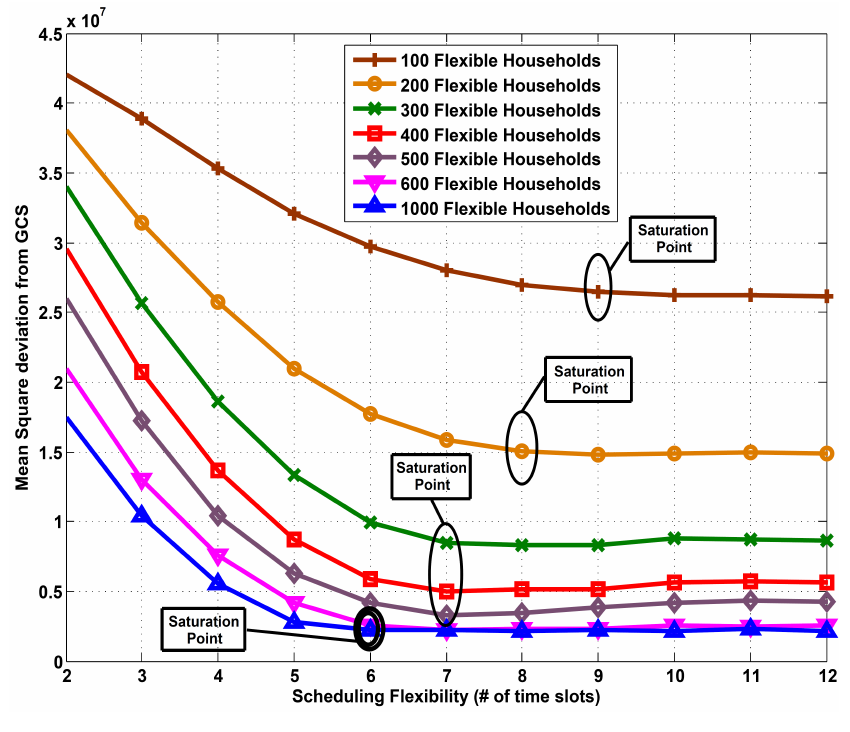
Figure 7. Participation rate of households vs . saturation point: partially distributed